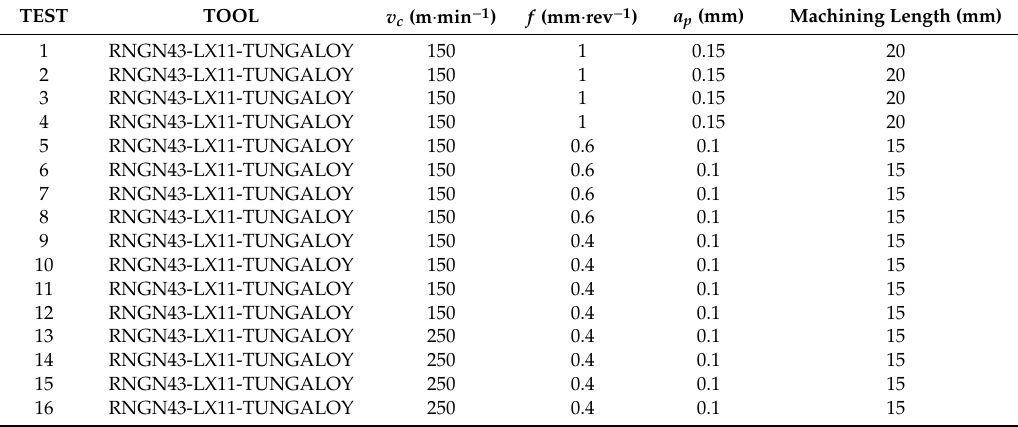
Table 4. Conditions of experimental verification.